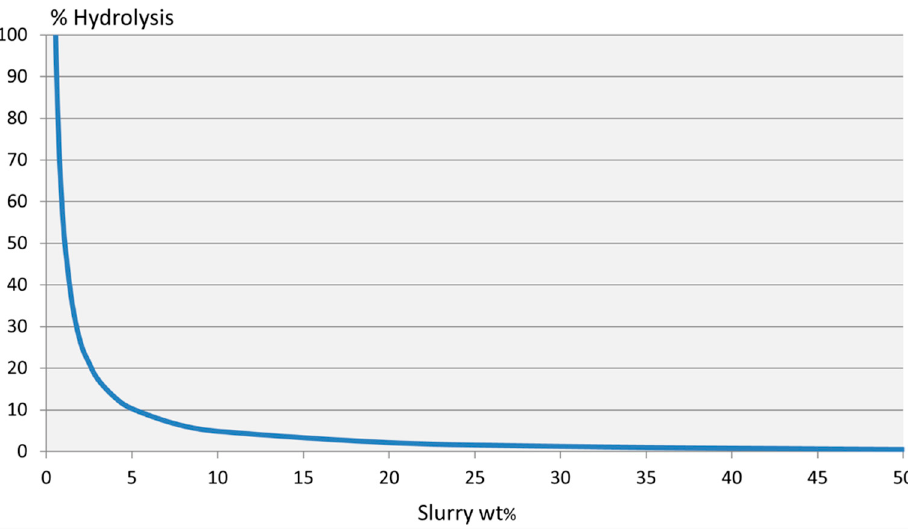
Figure 4. Percent hydrolysis of ZnB 3 O 4 (OH) 3 as a function of aqueous slurry concentration.